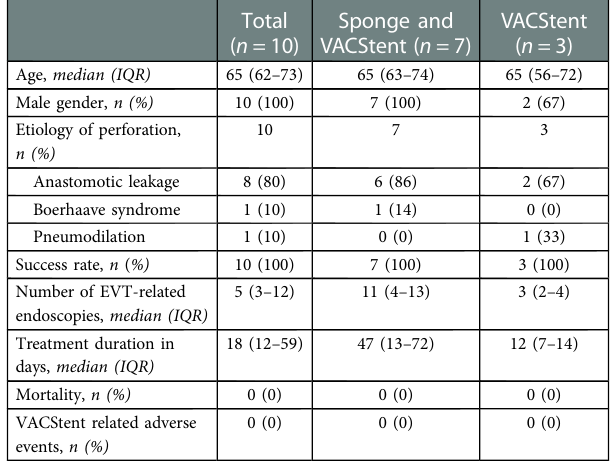
TABLE 1 Patient characteristics and